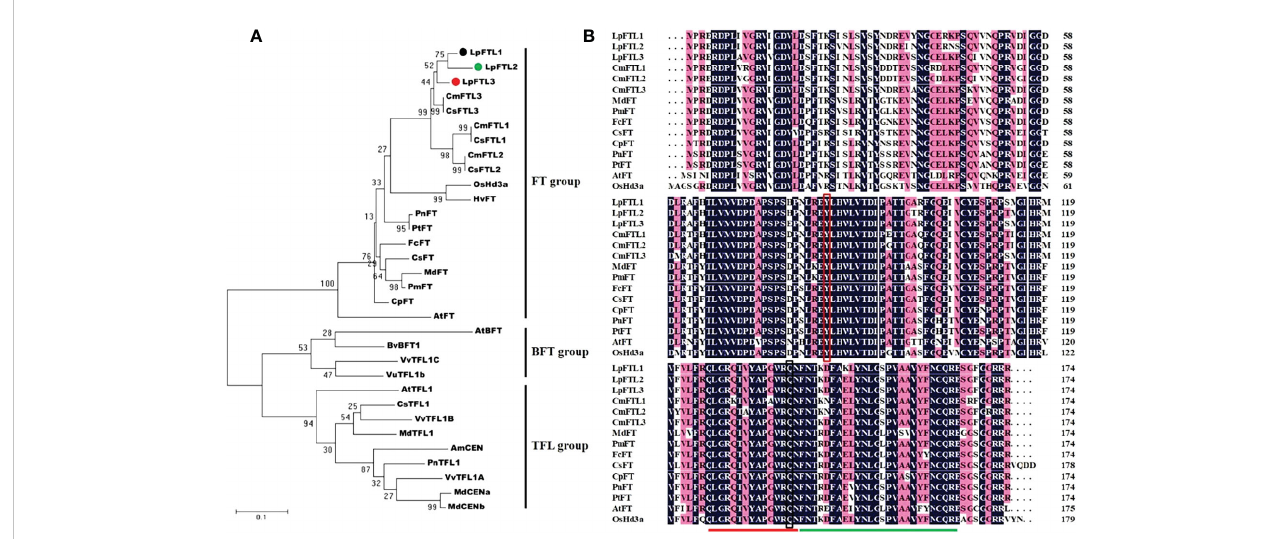
FIGURE 2 The sequences of LpFTL1, LpFTL2, and LpFTL3. (A) Phylogenetic tree of the deduced amino acid sequences of LpFTLs and other plant species FT sequences. (B) Comparison of the predicted amino acid sequences of L. paludosum FTLs and related proteins. Y85 (shown in red box) and Q140 (shown in black box) are essential for the formation of an external loop. The red and green lines highlight the conserved segments, required for FT-like activity.